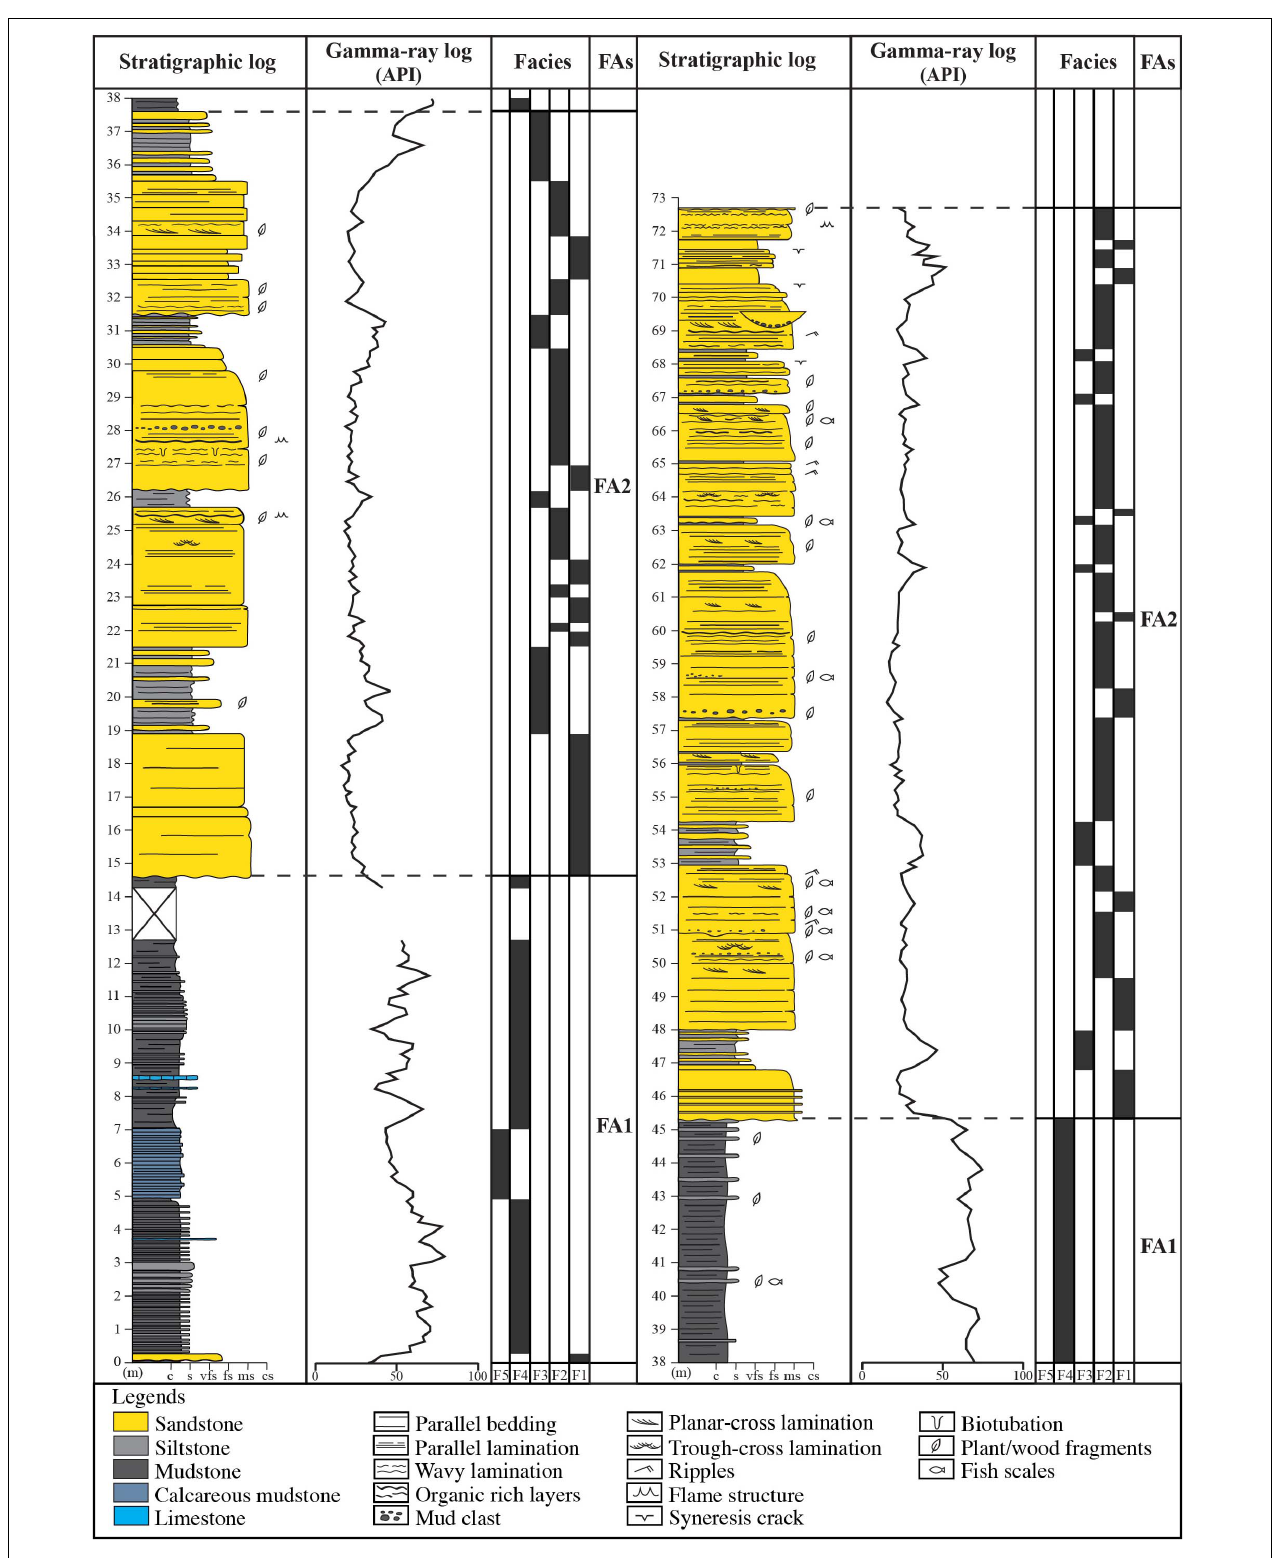
FIGURE 3 | The detailed stratigraphic log of the Huai Hin Lat outcrop correlates with the total gamma-ray log and identified sedimentary facies. ( FAs: Facies associations, F1: Structureless sandstone, F2: Structured sandstone, F3: Interbedded sandstone and siltstone, F4: Interbedded siltstone and mudstone, F5: calcareous mudstone facies; c: clay, s: silt, vfs: very fine sand, fs: fine sand, ms: medium sand, cs: coarse sand).